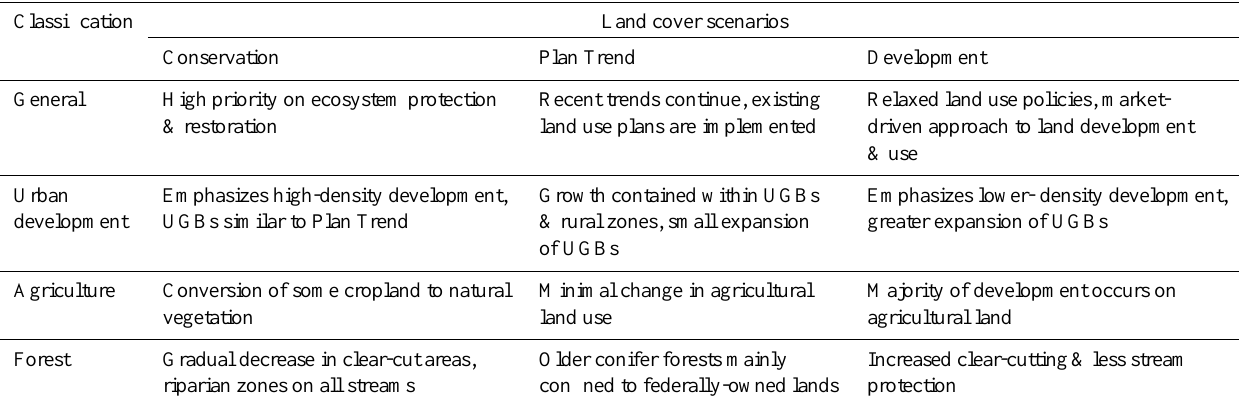
Table 2. Description of the three land cover scenarios used in this study to simulated land cover projections within the Fanno and Johnson Creek catchments by 2050 (Source: Hulse et al., 2004; Franczyk and Chang,